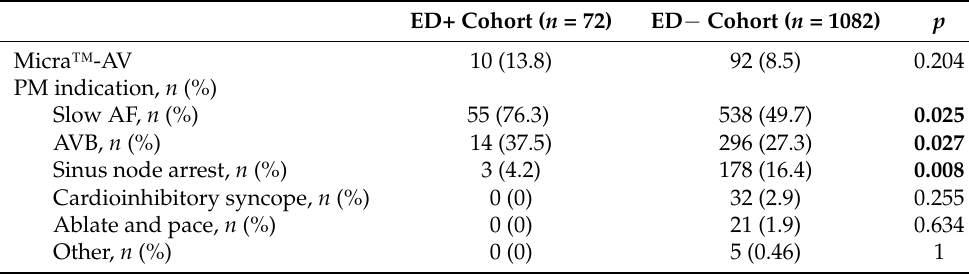
Table 2. LPM implantation